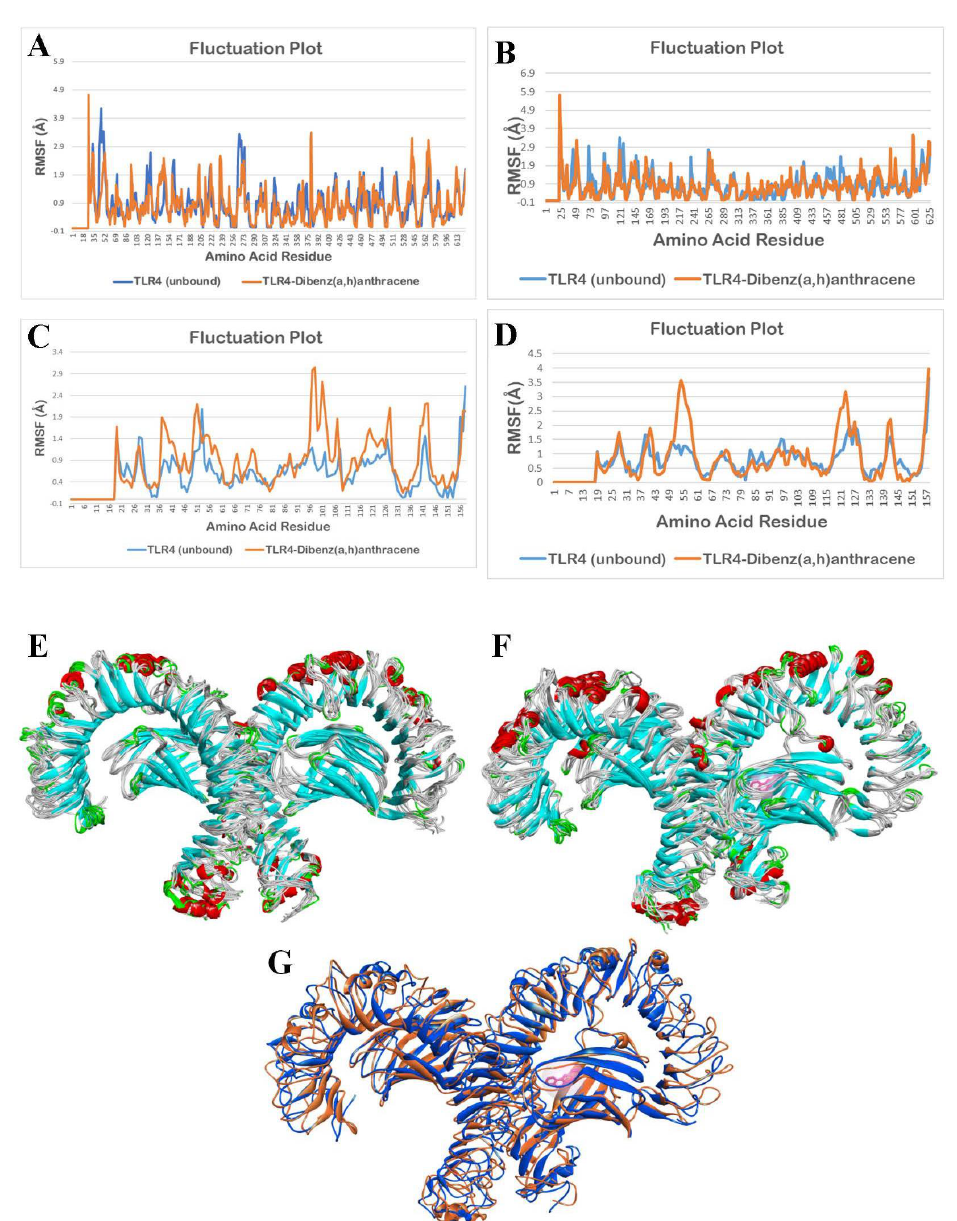
Figure 12. Molecular dynamics simulation of unbound and DahA bound TLR4 structures: ( A ) fluc- tuation plot of the number of amino acid residues of unbound (blue) and bound structure (orange) of TLR4 chain A, ( B ) fluctuation plot of the number of amino acid residues of unbound (blue) and bound structure (orange) of TLR4 chain B, ( C ) fluctuation plot of the number of amino acid residues of unbound (blue) and bound structure (orange) of TLR4 chain C, ( D ) fluctuation plot of the number of amino acid residues of unbound (blue) and bound structure (orange) of TLR4 chain D, ( E ) super- imposition of unbound TLR4 structures from 0 ns to 10 ns, ( F ) superimposition of DahA bound TLR4 structures from 0 ns to 10 ns, and ( G ) superimposition of unbound TLR4 (blue) at 0 ns and DahA (pink) bound TLR4 (orange) at 10 ns.